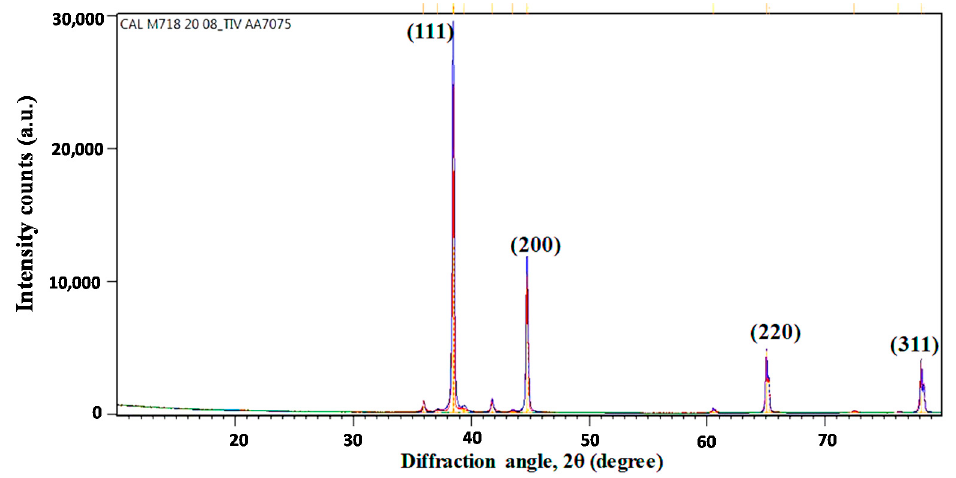
Figure 10. XRD pattern of the received matrix Al7075 powder.